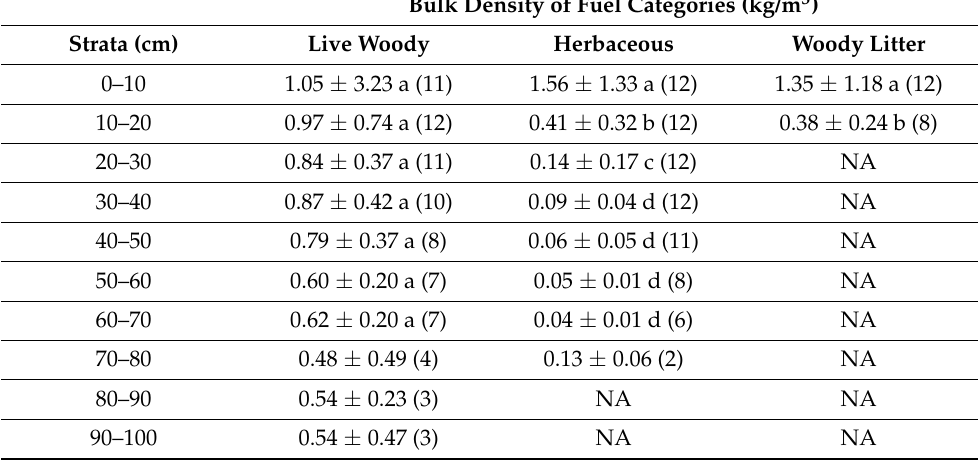
Strata (cm) Live Woody